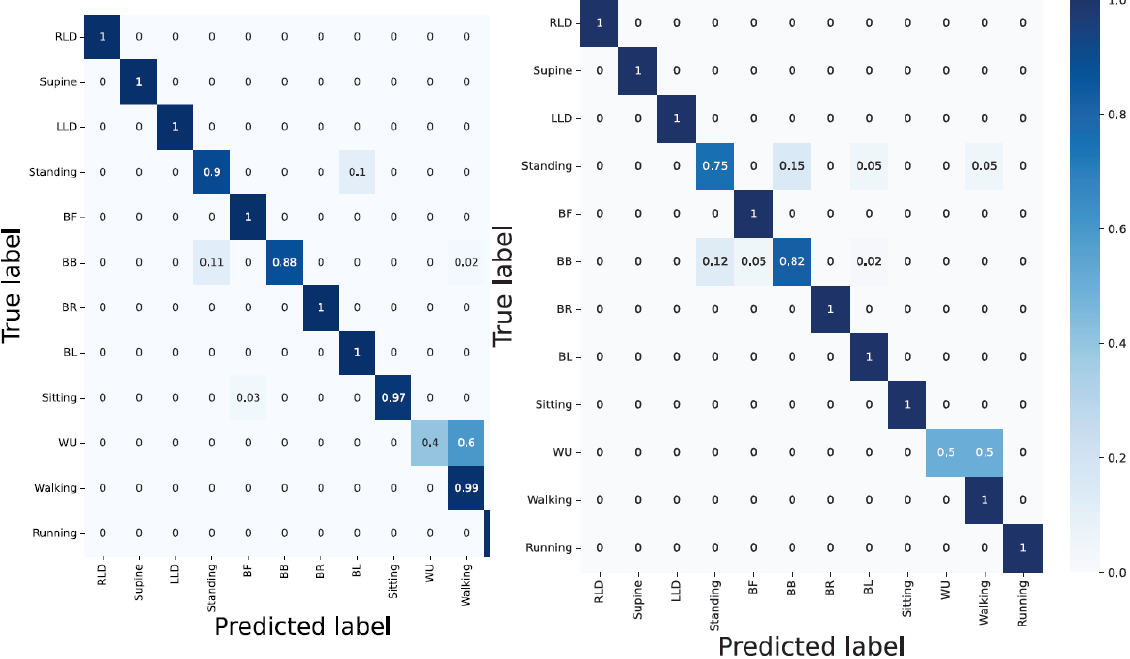
Figure 12. The hybrid model delivers a good performance with respect to lying down associated and bending activities, but is unable to resolve the WU